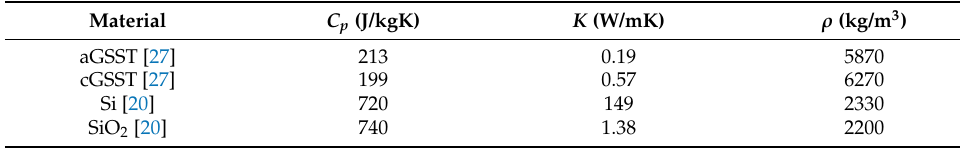
Table 1. Relevant material parameters used for simulation.